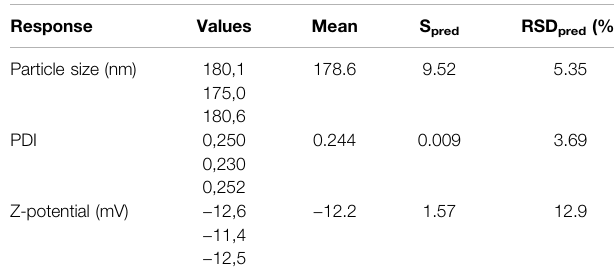
TABLE 3 | Individual values, mean, prediction error (S pred ), and relative standard deviation (RSD) were obtained for the particle size (nm), PDI and Z-potential (mV) of the optimized